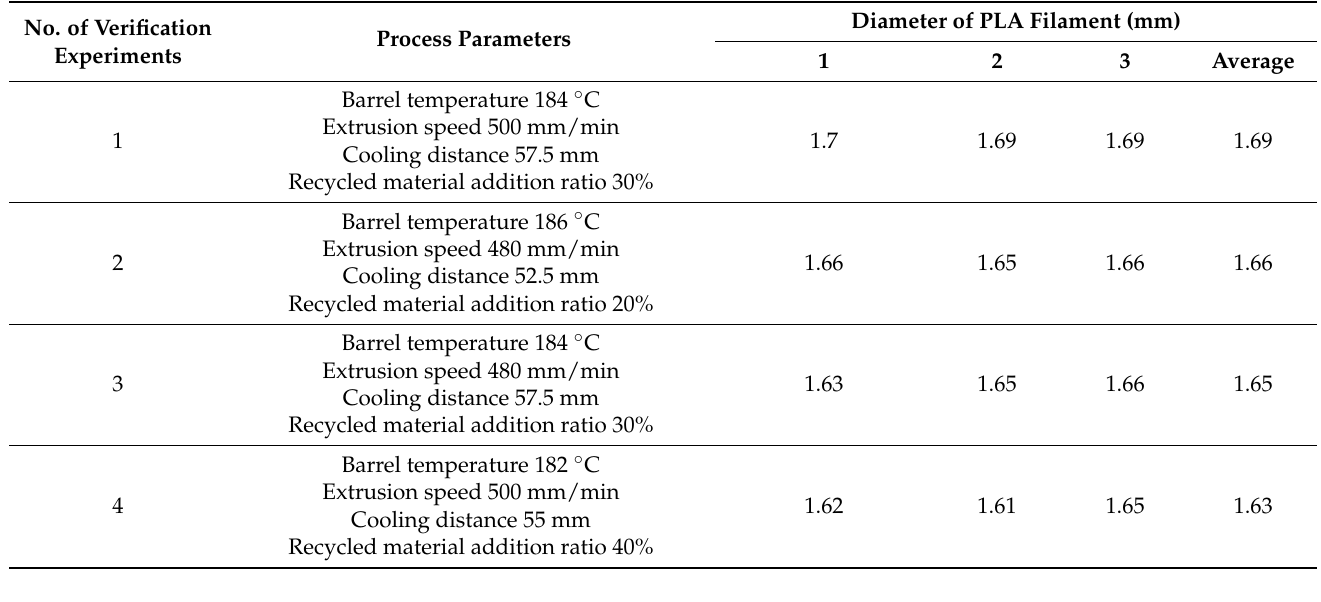
Table 5. Results of verifying the optimal process parameters.